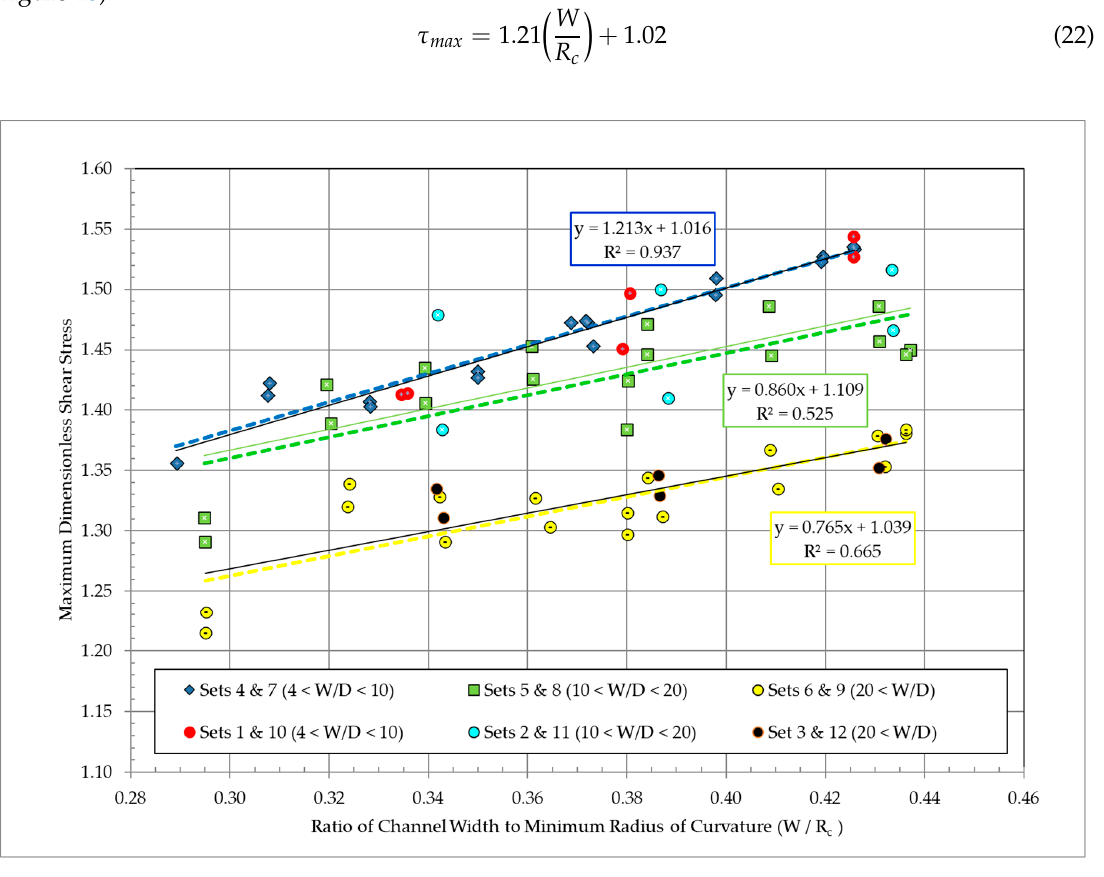
Figure 48. Correlations, using all 12 simulations sets, between the maximum dimensionless near-bank shear stress and the ratio of channel top width to minimum radius of curvature.